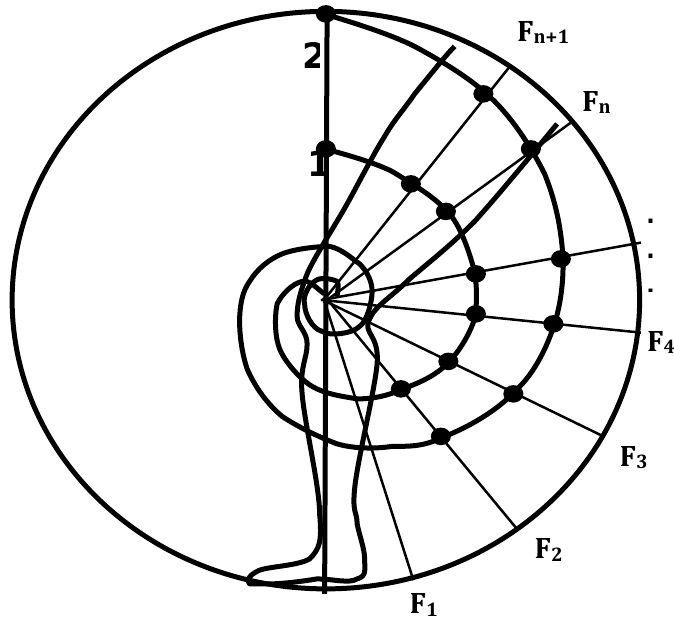
Fig.1. Graphic picture of static effort change (dF/d j ) depending on unbending angle in joint. Note: 1. Logarithmic spiral of change (dF/d j ) after intensive training. 2. Logarithmic spiral of change (dF/d j ) with sportsman’s high workability.